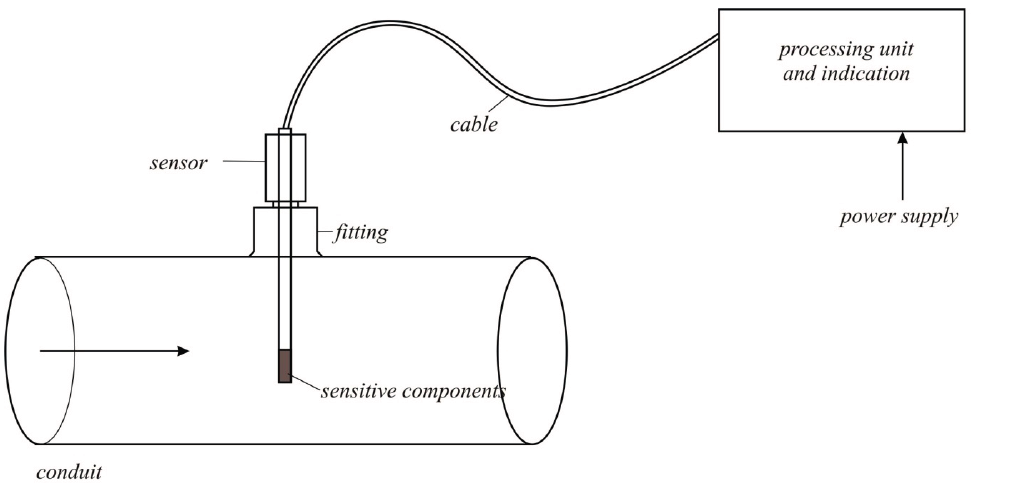
Figure 7. The thermo-anemometric flowmeter schematic